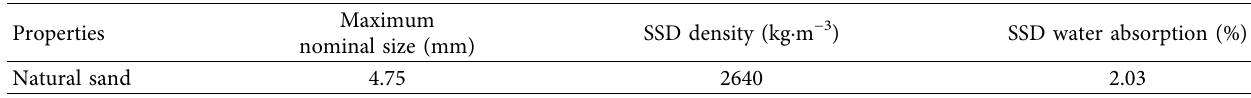
Table 2: Properties of the natural sand.